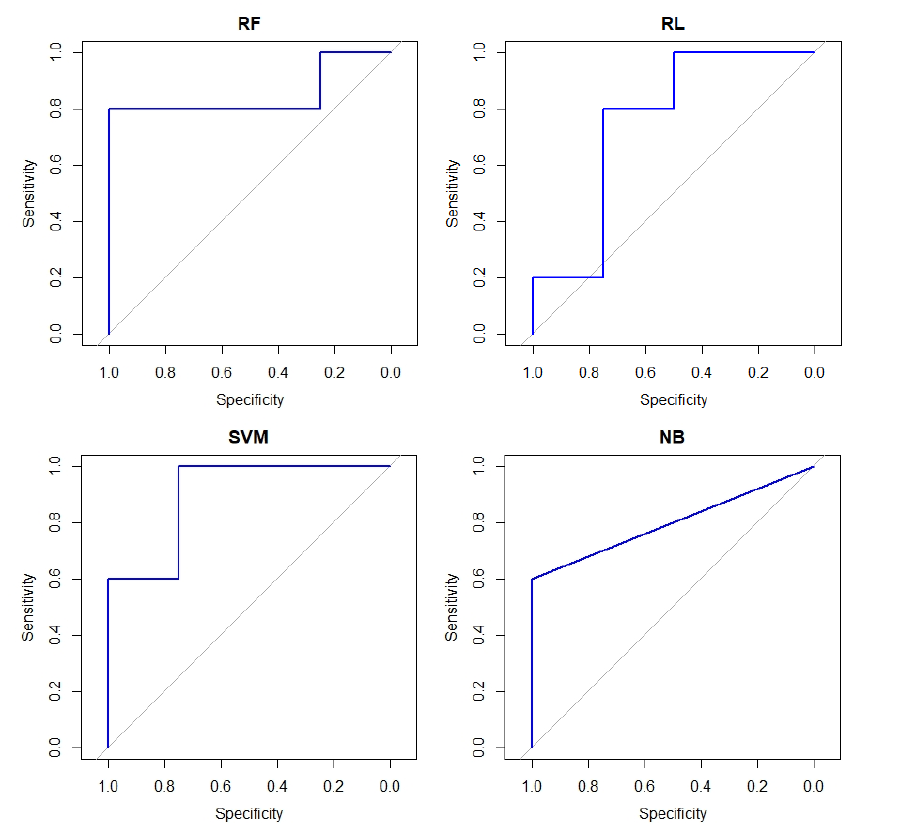
Figure 3. ROC curves of the four machine learning classification models, with the 21 selected features, blind test